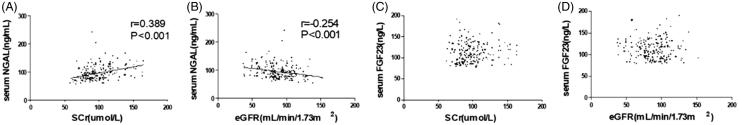
Correlation between SCr and serum NGAL (A), between eGFR and serum NGAL (B), between SCr and serum FGF23 (C), between eGFR and serum FGF23 (D).